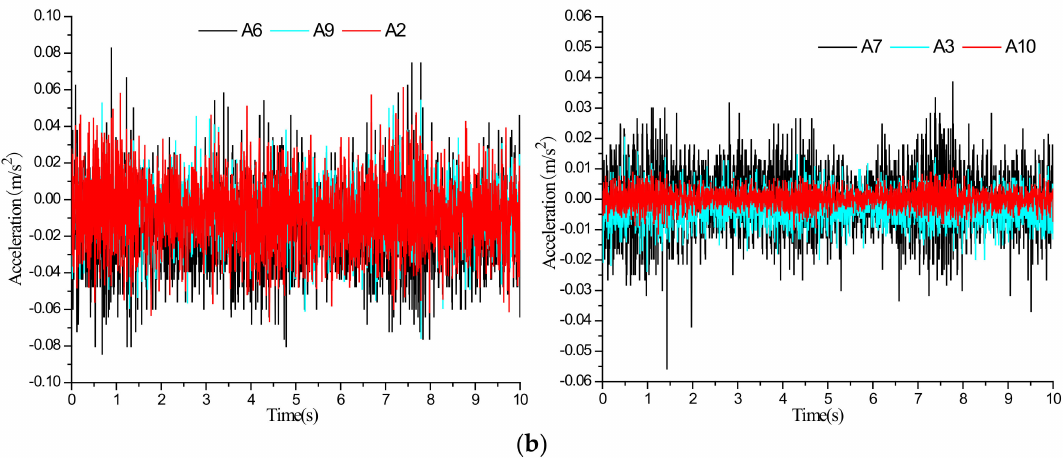
Figure 10. Acceleration time series under the scenario of hanging wall descend 1 cm: ( a ) vibration exciter at 60 cm; ( b ) vibration exciter at 100 cm.